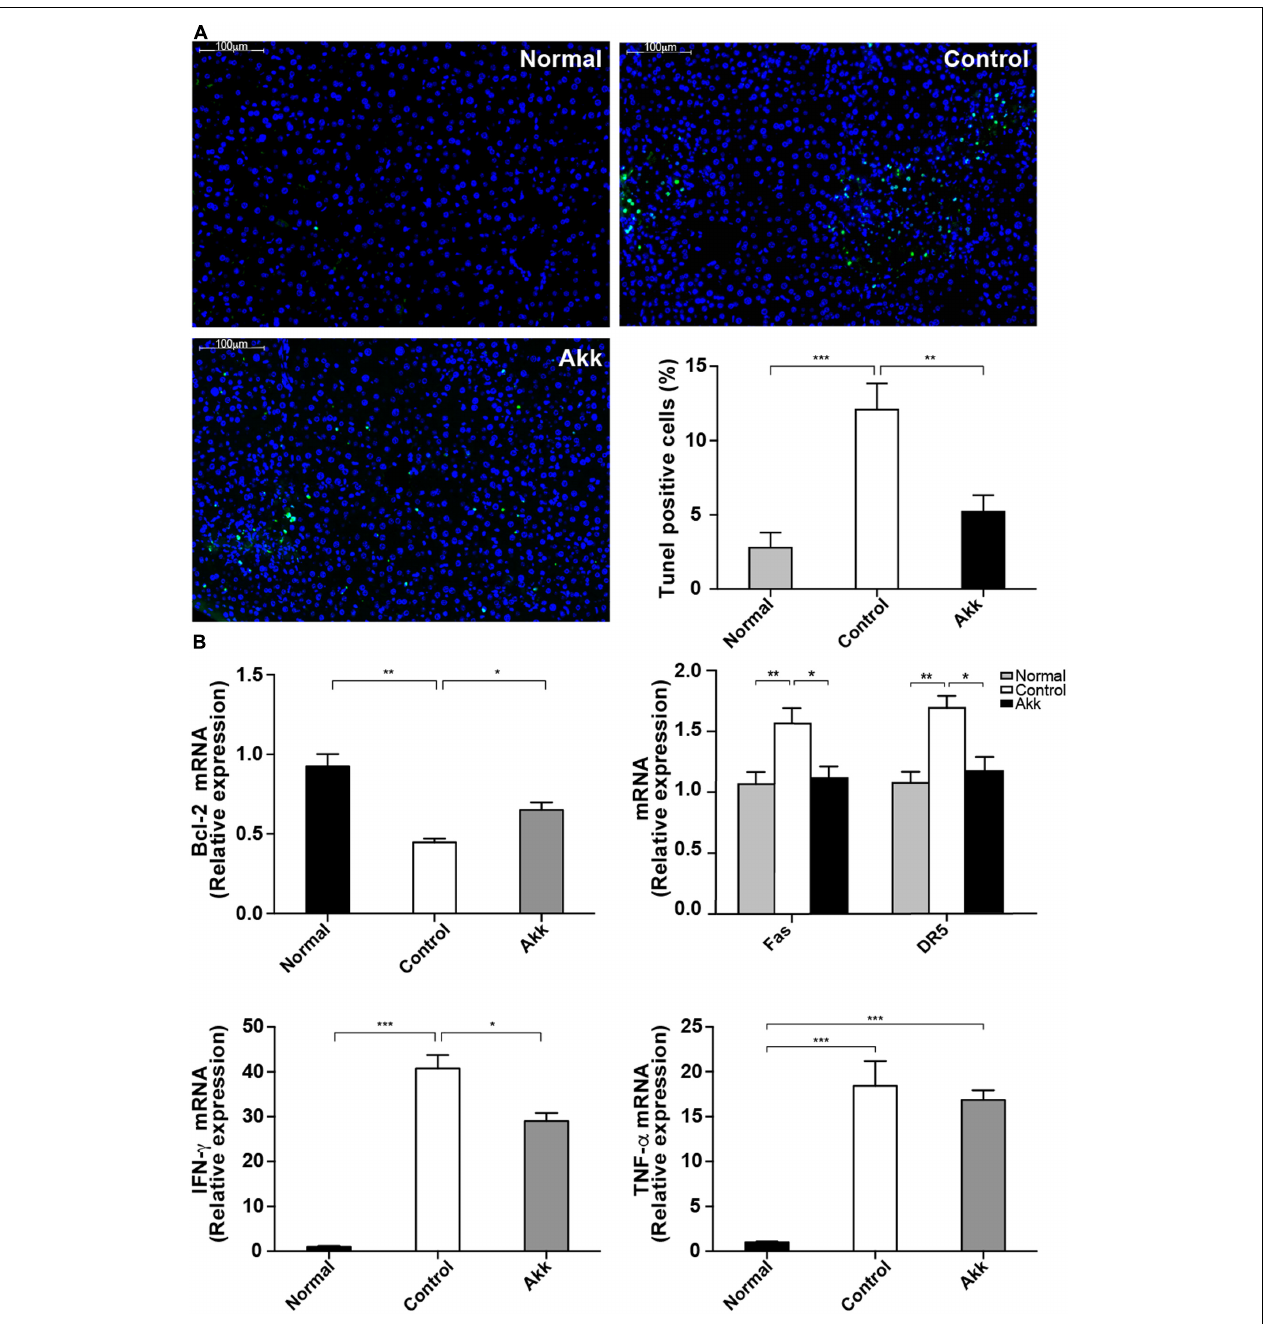
FIGURE 3 | Akkermansia muciniphila suppressed Con A-induced hepatocyte apoptosis. (A) TUNEL assays of liver histology 8 h after Con A injection. There was extensive damage in group Control, but only sporadic apoptosis was observed in group Akk (scale bar, 100 µ m). Percentage of apoptotic cells in the liver was significantly lower in group Akk ( n = 7–8 per group). (B) Liver expression of genes related to apoptosis and inflammation ( n = 6–8 per group). mRNA level of an important anti-apoptotic factor, Bcl-2 , was markedly reduced in group Control, whereas it was significantly elevated in group Akk. Expression of both Fas and DR5 was diminished. IFN- γ was substantially reduced in group Akk, but expression of TNF- α was not significantly influenced. Data are shown as the mean ± SEM. ∗ P < 0.05, ∗∗ P < 0.01, ∗∗∗ P < 0.001 by post hoc ANOVA one-way statistical